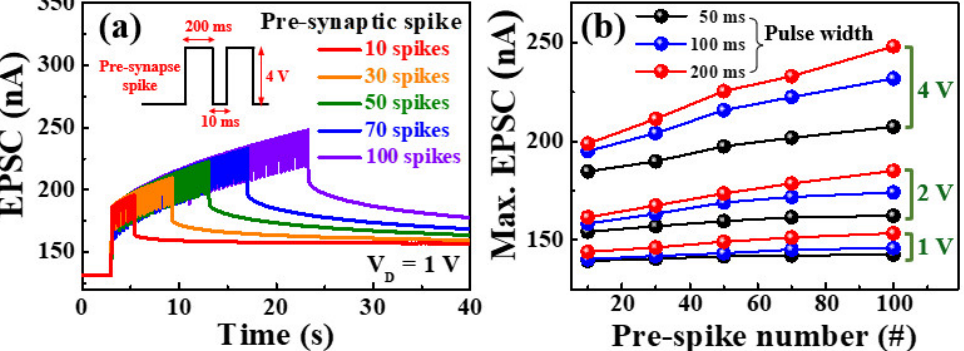
Figure 7. ( a ) Excitatory post-synaptic current (EPSC) facilitated by pre-synaptic stimulation of multiple pre-synaptic stimulation spikes (0–100 cycles). ( b ) Maximum EPSC according to pre-spikes number.